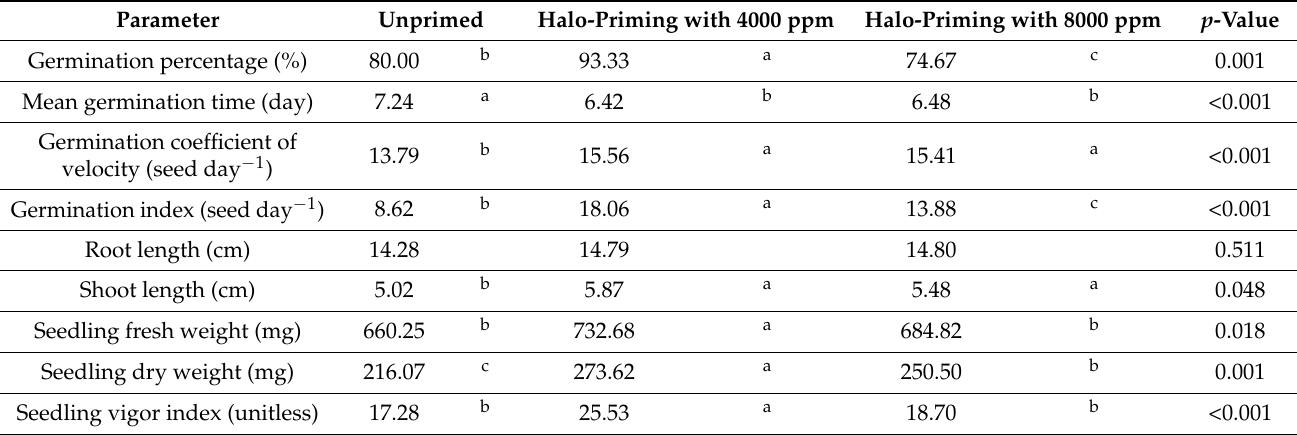
Table 3. Impact of seed halo-priming treatments with 4000 and 8000 ppm versus unprimed seeds on maize seed germination and seedling vigor